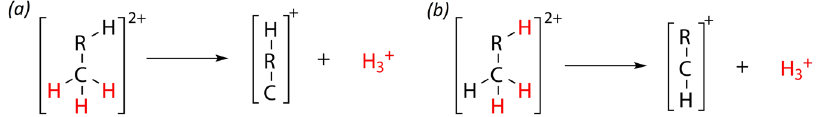
Figure 1. Two formation pathways for H 3 + from a doubly ionized precursor state CH 3 RH 2 + . ( a ) Association of three hydrogen atoms initially attached to the same carbon atom. ( b ) Association of two hydrogen atoms bound to a carbon atom with a hydrogen atom from an adjacent group. The hydrogen atoms that take part in H 3 + formation are indicated in